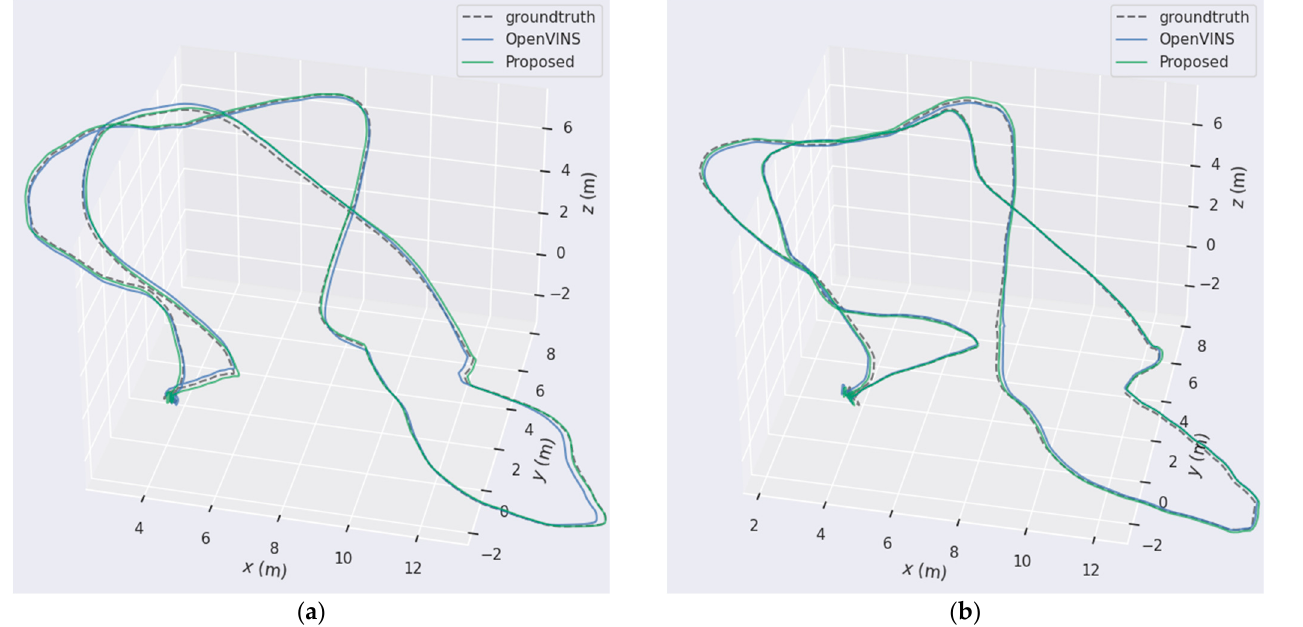
Figure 5. The comparison of estimated trajectory between OpenVINS and the proposed method for the ( a ) MH-04-difficult and ( b ) MH-05-difficult sequences.